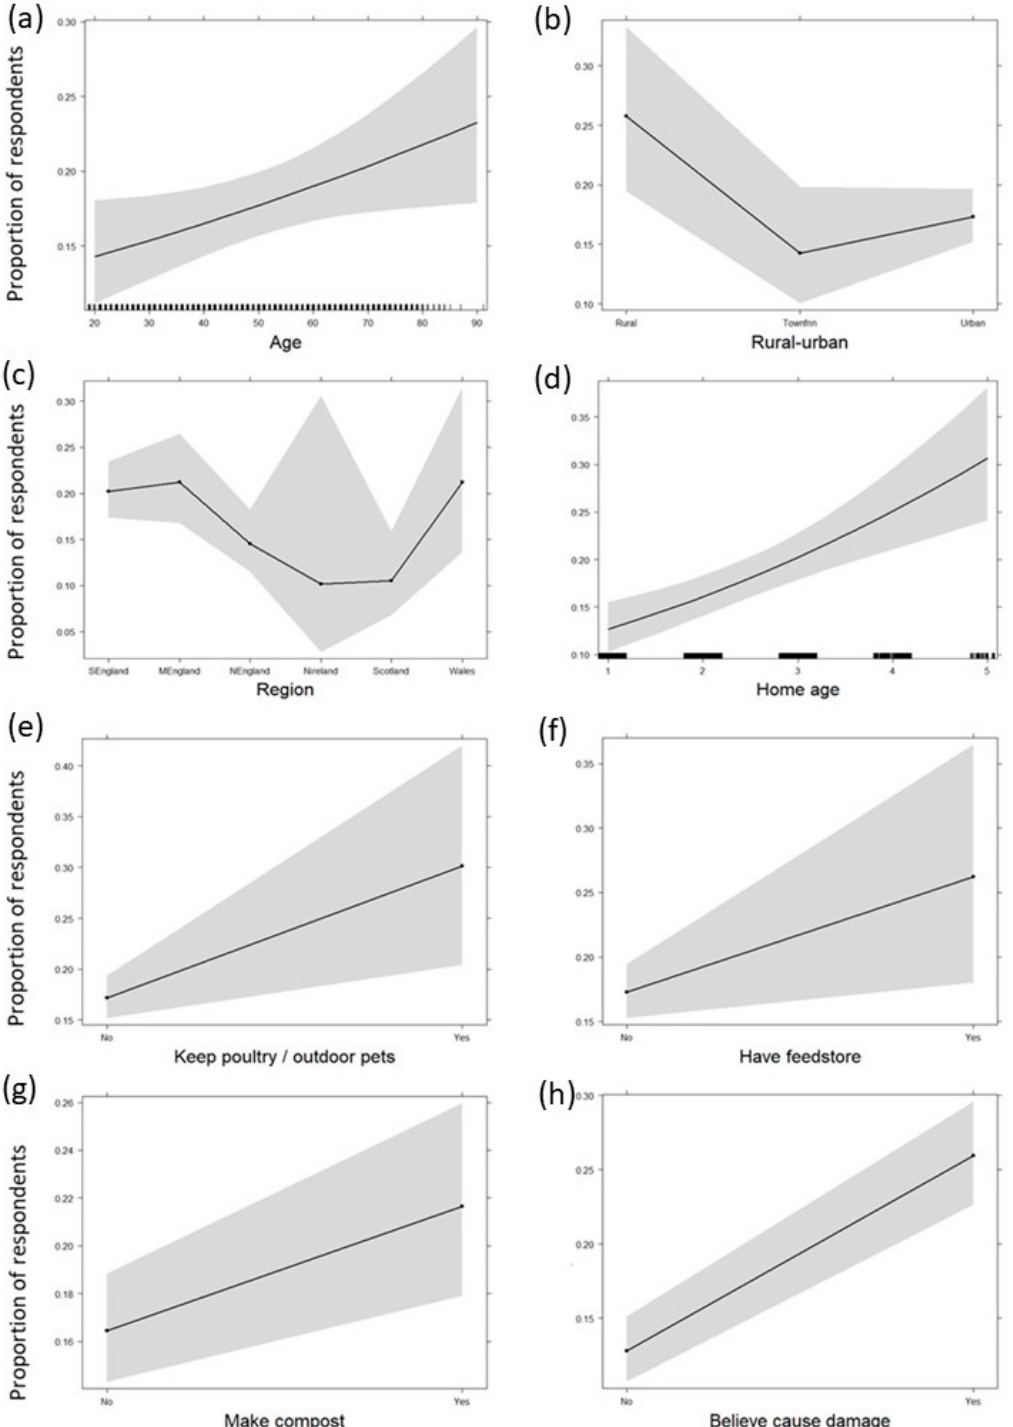
Figure 8. Drivers of respondents’ experience of problems with rats (marginal effects in logistic regression models), including: ( a ) respondent age; ( b ) whether respondent lives in an urban or rural area; ( c ) region; ( d ) home age; and whether respondent ( e ) keeps poultry or outdoor pets; ( f ) has an